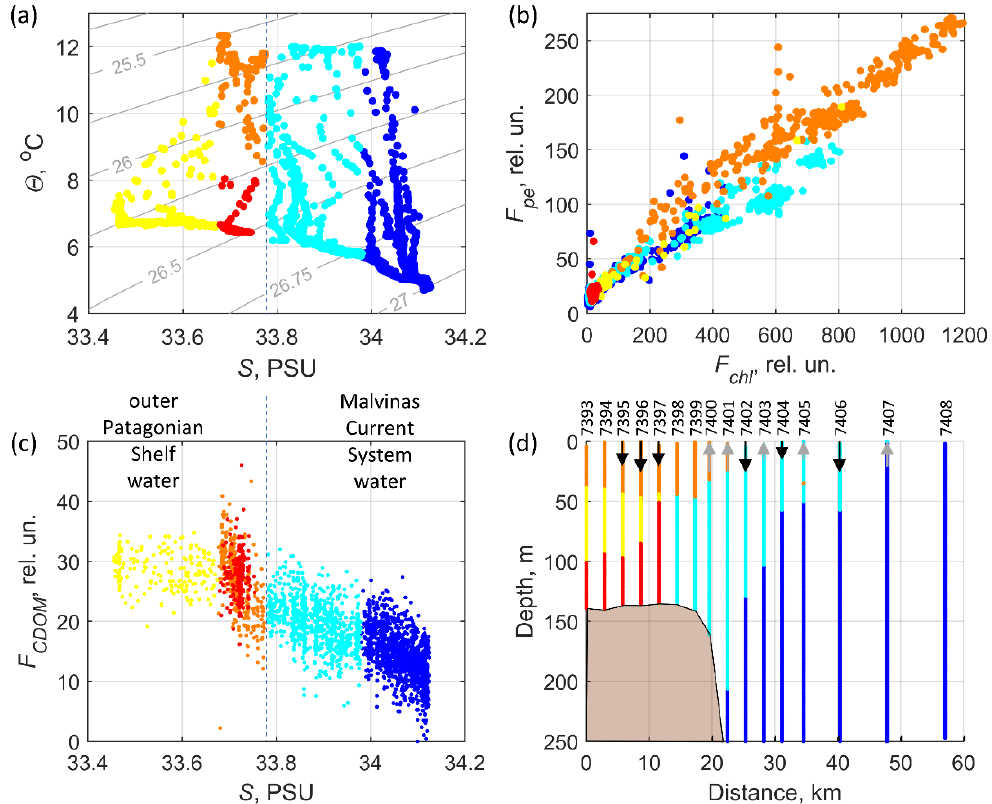
Figure 6. Scatter plots of “potential temperature—salinity” ( a ); “phycoerythrin—chl- a fluorescence intensity” ( b ); “CDOM fluorescence intensity—salinity” ( c ); and a scheme of the distribution of identified water masses along the section and vertical directions in the UML ( d ). Colors are described in Table 2.